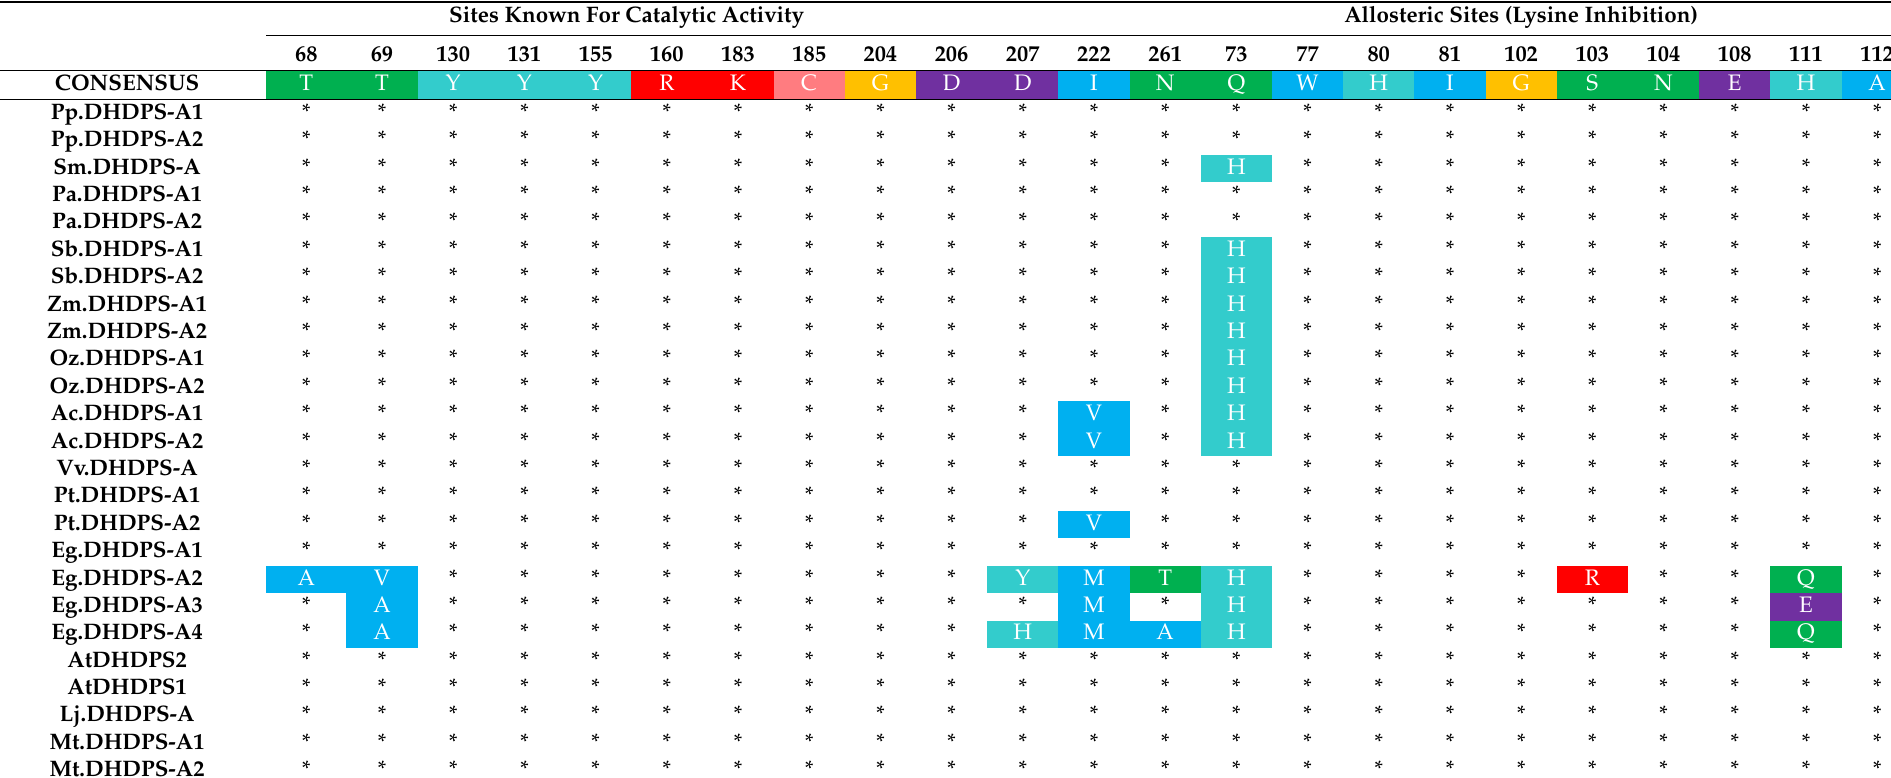
Table 1. Amino acid substitution table adapted from [19] for specific sites in DHDPS known for catalytic activity and lysine inhibition allosteric sites for Physcomitrella patens (Pp) , Selaginella moellendorffii (Sm) , Picea abies (Pa) , Oryza sativa (Os) , Zea mays (Zm) , Sorghum bicolor (Sb) , Aquilegia coerulea (Ac) , Vitis vinifera (Vv) , Eucalyptus grandis (Eg) , Arabidopsis thaliana (At) , Populus trichocarpa (Pt) , Glycine max (Gm) , Vigna unguiculata (Vu) , Phaseolus vulgaris (Pv) , Pisum sativum (Ps) , Medicago truncatula (Mt) and Lotus japonicus (Lj) , with amino acid position numbering from N. sylvestris DHDPS [20]. G. max protein names are underlined. The consensus amino acid sequence is based on the multiple alignments of 156 legume DHDPS protein sequences (see Materials and Methods). The amino acid color scheme was adapted from [30], with each color representing different physicochemical characteristics of the amino